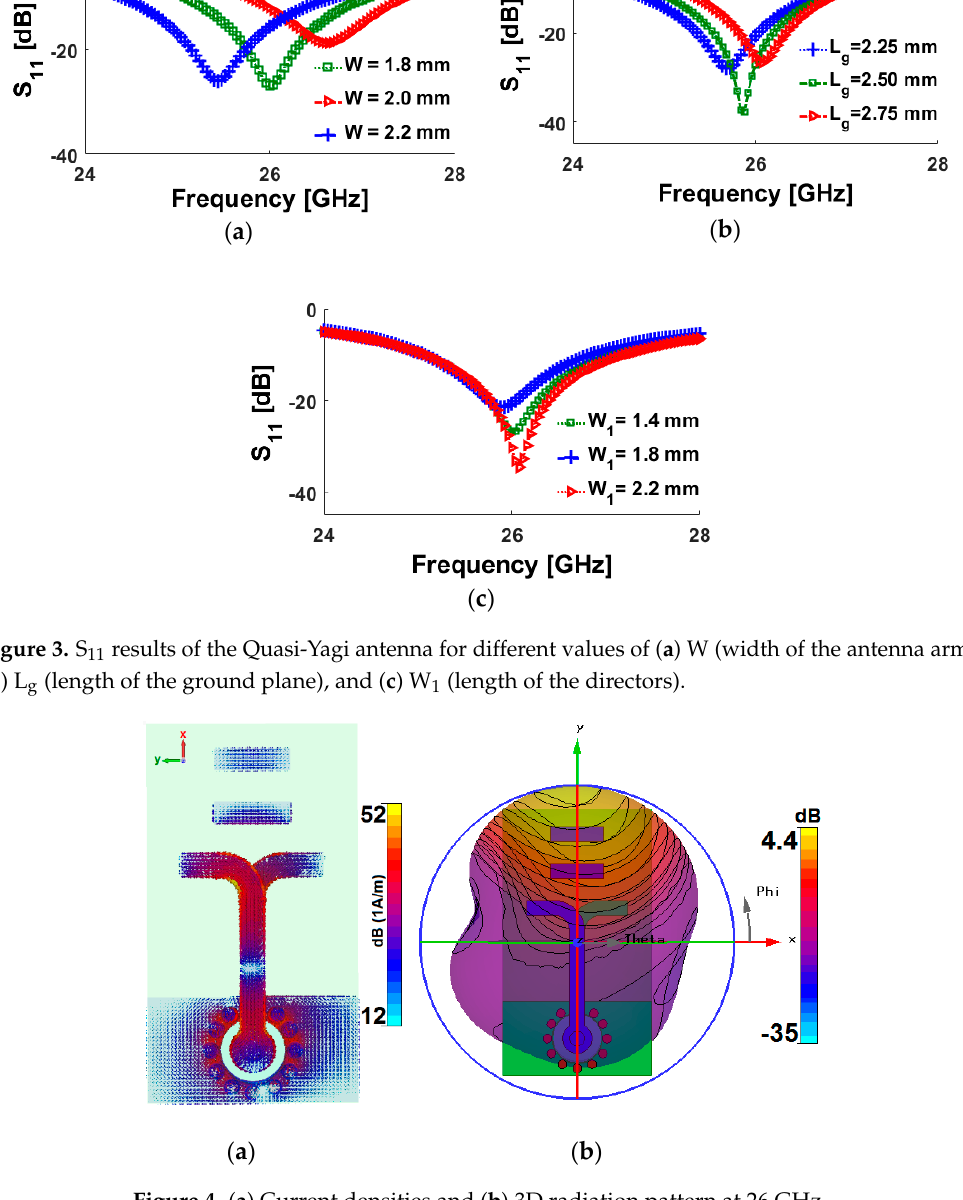
Figure 4. ( a ) Current densities and ( b ) 3D radiation pattern at 26 GHz.